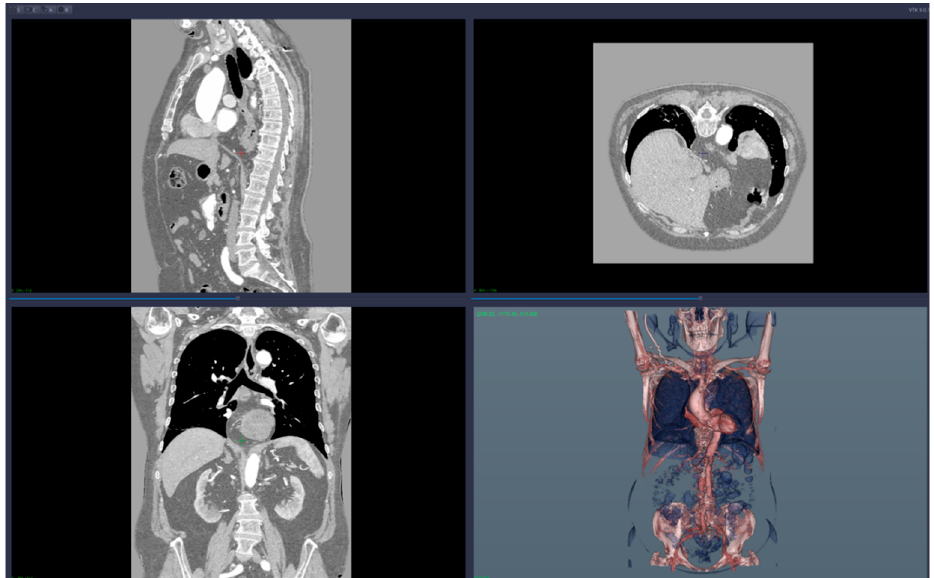
Figure 1. Images of the 3D CT reconstruction and 2D sections.